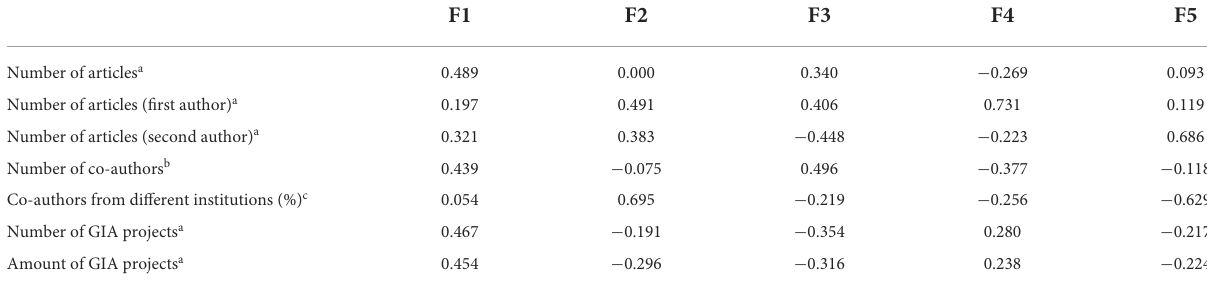
TABLE 5 Eigenvectors.